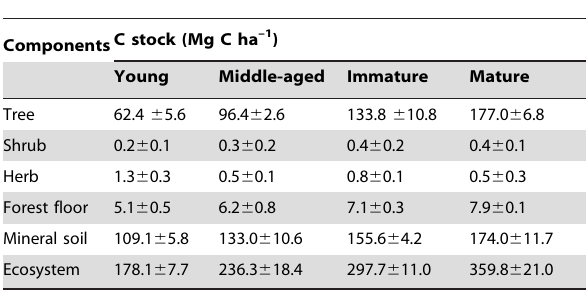
Table 5. C pools of ecosystem components in P. tabulaeformis